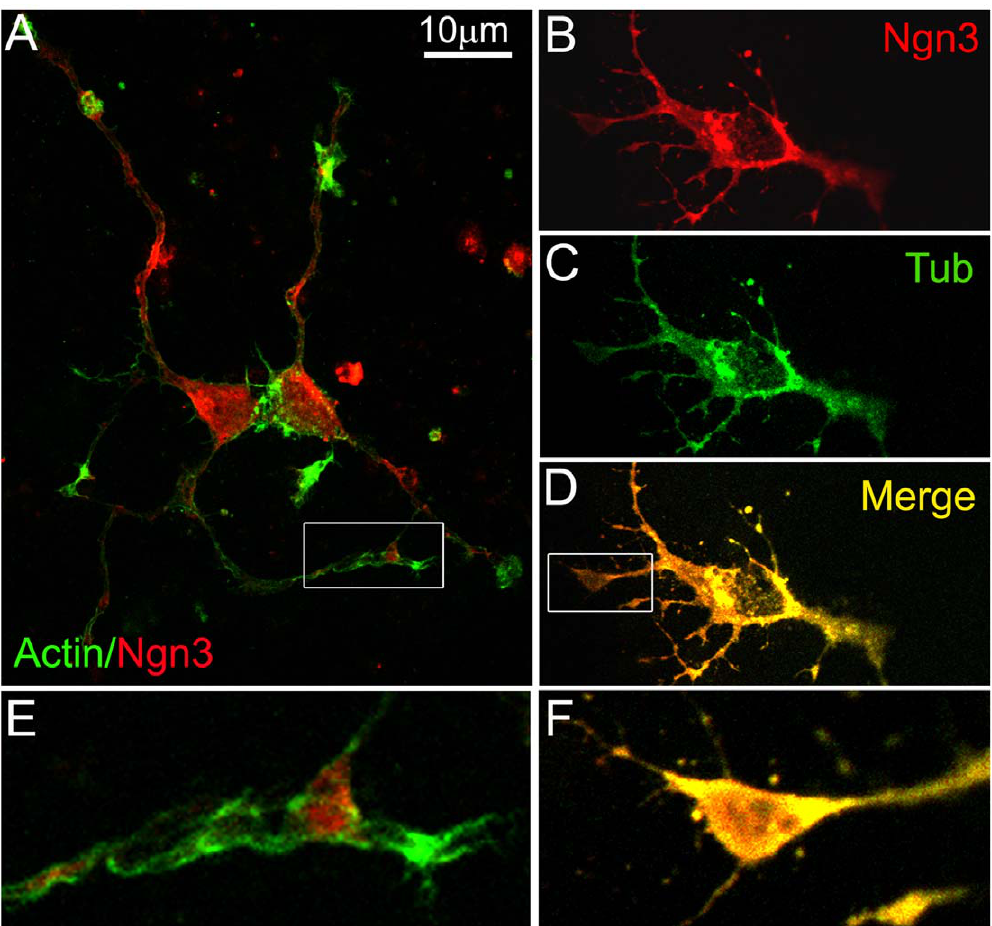
Figure 6. Ngn3 co-localizes with microtubules and not with actin filaments. At 3 DIV, neurons were immunostained for Ngn3 (red) and stained for actin with phalloidin (green) (panels A,E) or immunostained for Ngn3 (red) and tubulin (green) (panels B-D and F). ( A and D ) Representative confocal images. ( E and F ) Detail of growth cones. Note the association of Ngn3 with microtubules. In contrast Ngn3 was clearly not associated with actin filaments.